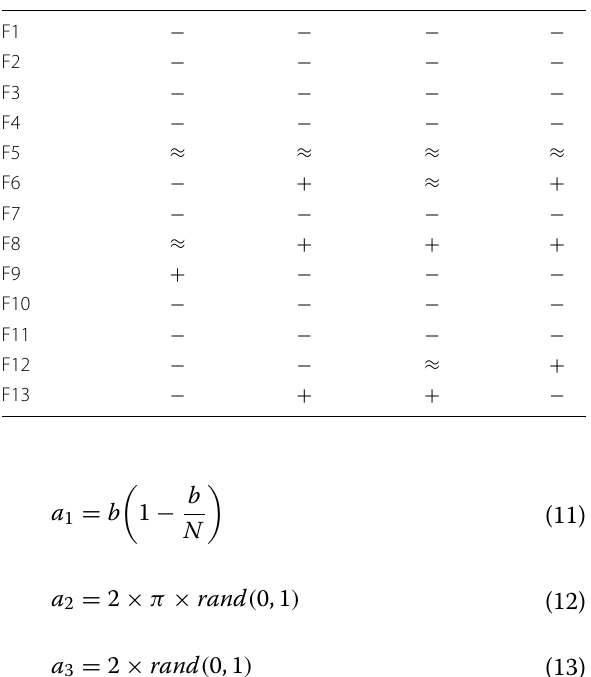
The flow chart of the ISCA is shown in Fig. 3. The algo- Table 2 Wilcoxon signed-rank test results on unimodal and multi-model functions indicating the inferior (-), superior ( ), or rithm mainly has three steps, i.e., initialization, iteration, + equivalent ( ), method in comparison to the proposed method and termination. In the first step, the algorithm initial- ≈ izes the parameters, such as the maximum number of Function SCA ALO SSA iterations (N), search agent number (c), number of vari- ables to be tuned (d) with their upper (ub) and lower (lb) bound, first set of search agents (solution). In the second